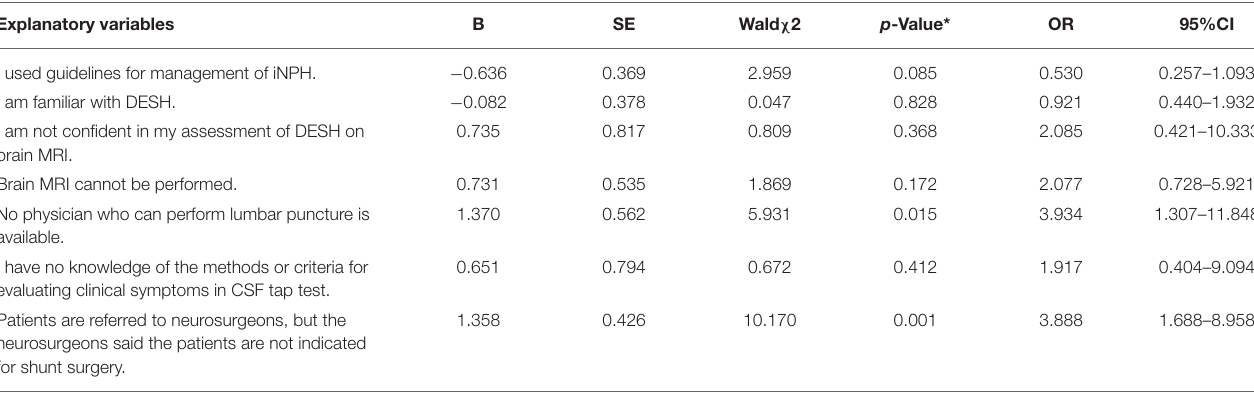
TABLE 1 | Predictors of patient referral from MCDs to other hospitals when iNPH is suspected. Explanatory variables B SE Wald χ 2 p -Value* OR